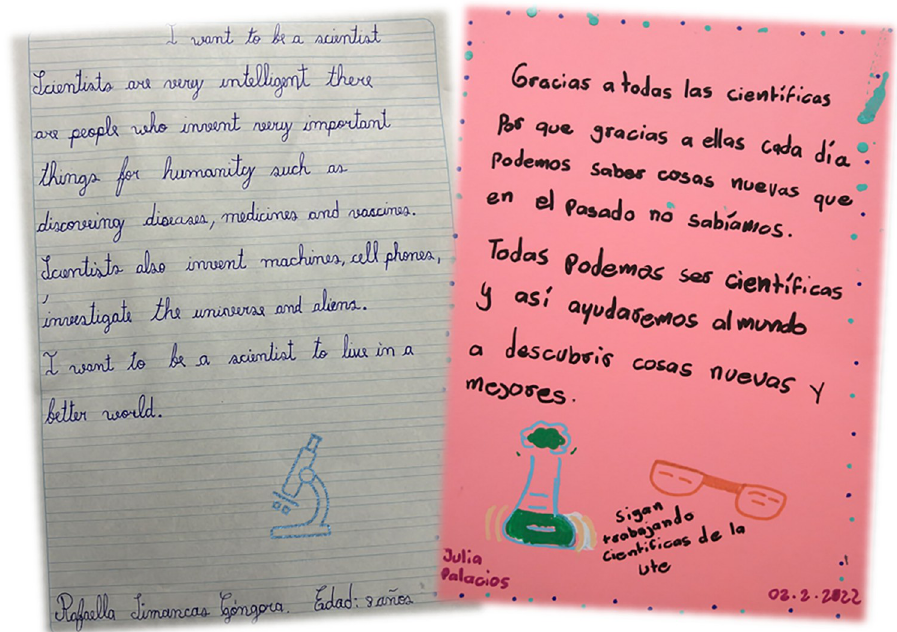
Fig 1. Letters of girls interested in science (English and Spanish) (Written by Rafaella Simancas and Julia Palacios).